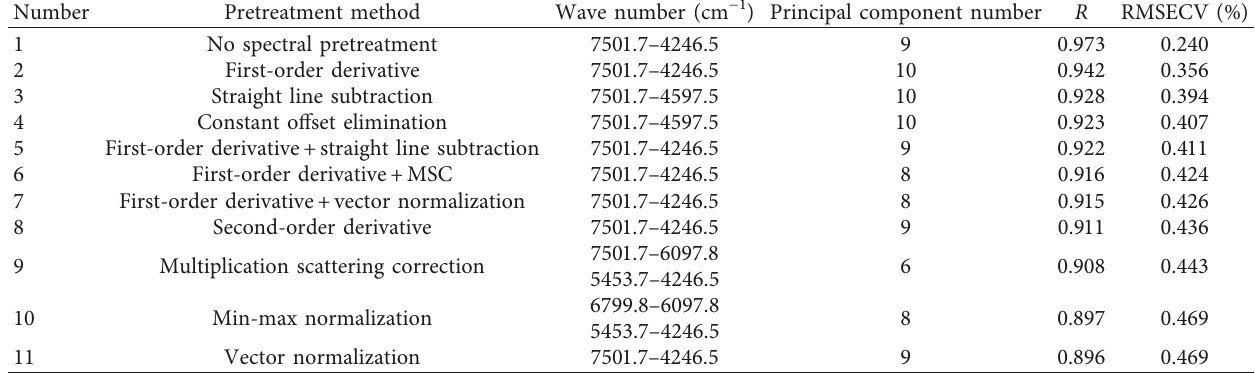
Table 3: The result of carbon spectrum using eleven spectral preprocessing